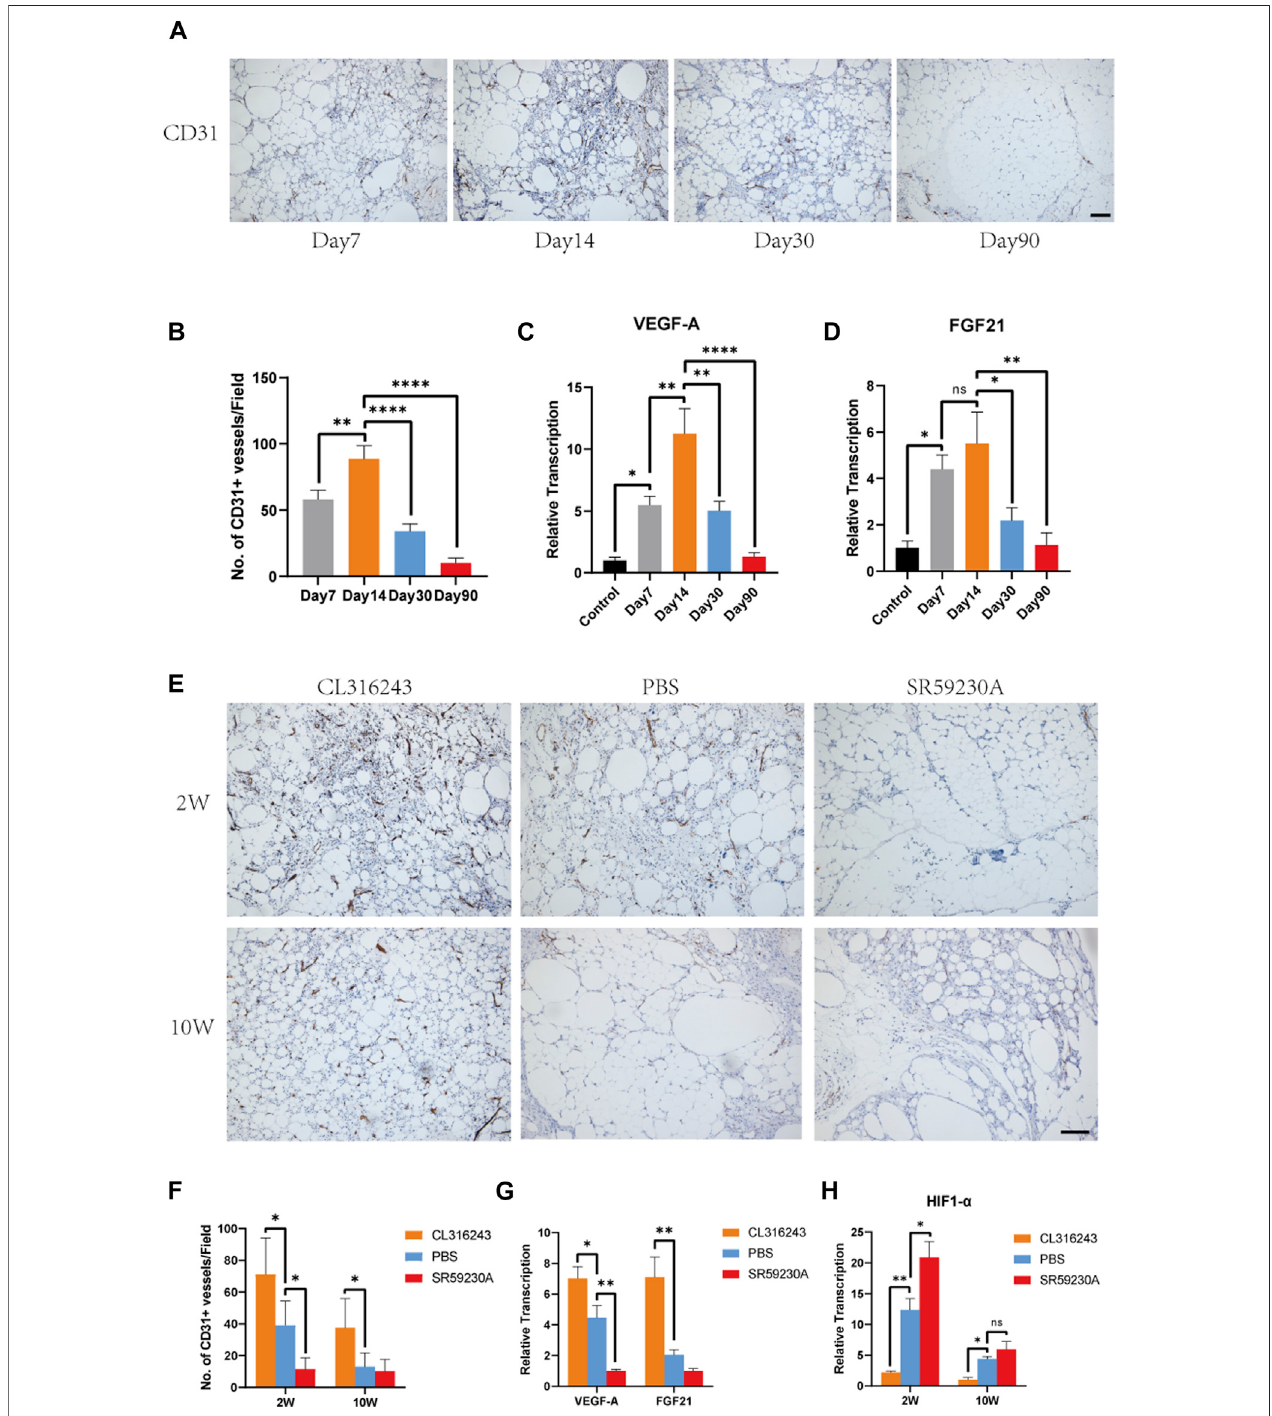
FIGURE 4 | Beige adipocyte formation was associated with early angiogenesis and the production of VEGF-A and FGF21. (A) Angiogenesis of fat grafts was superioratday 14than day7,30and90. (B) Quanti fi cation ofCD31-positivecellsat differenttime points. (C and D) Expressionlevelsofangiogenicgenes,VEGF-Aand FGF21. (E) Angiogenesis in the fat grafts 2 weeks and 10 weeks after transplantation, identi fi ed using immunohistochemical staining for CD31. (F) Number of CD31 + vessels at week 2 and week 10. (G) Expression of the Vegfa and Fgf21 genes in the fat grafts at week 2, measured using quantitative RT-PCR. (H) Expression of HIF1- α associated with hypoxia at week 2 and week 10. (* p < 0.05; ** p < 0.01; **** p < 0.0001). Scale bar = 50 μ m.